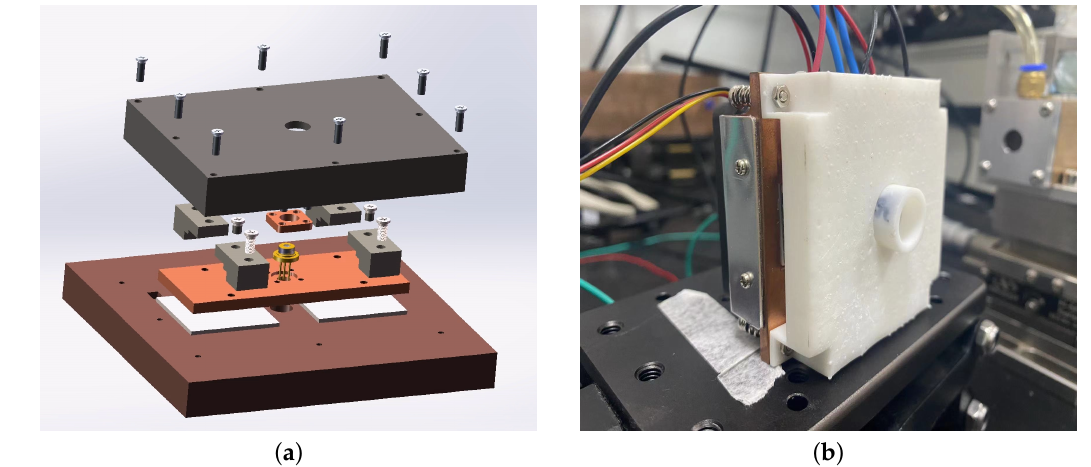
Figure 4. ( a ) Package strategy for the laser; ( b ) The picture of the packaged laser.